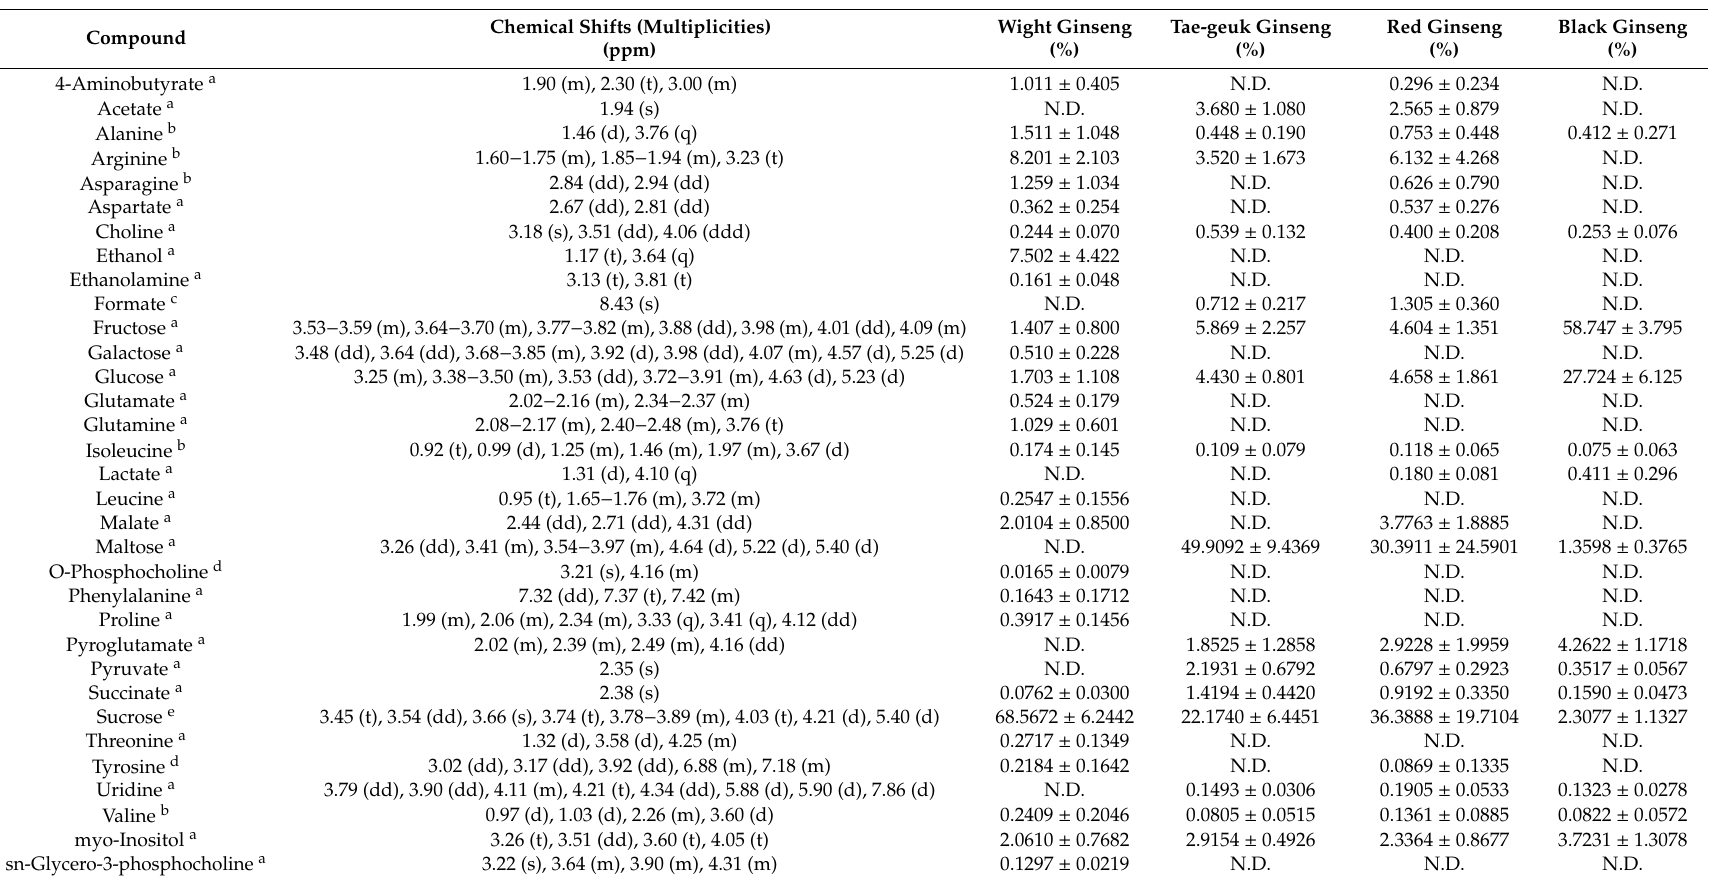
Table 1. Identified and quantified metabolites in four processed ginseng products from 1 H − NMR spectra. Relative concentrations were calculated against the total area. Values are means (%) ± standard